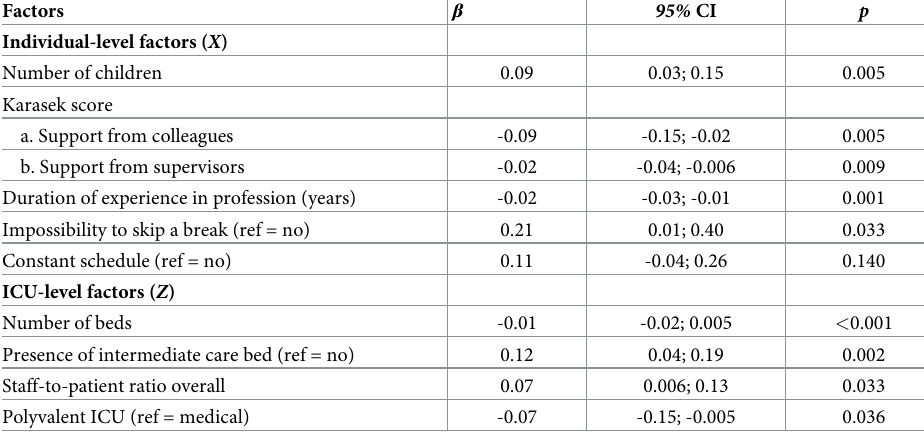
Regression coefficients ( β ) are provided with their 95% confidence interval (CI) and their p-value ( p ). p < 0.05 was considered statistically